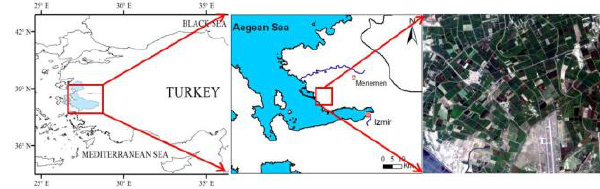
Figure 1. The study area: Menemen Plain